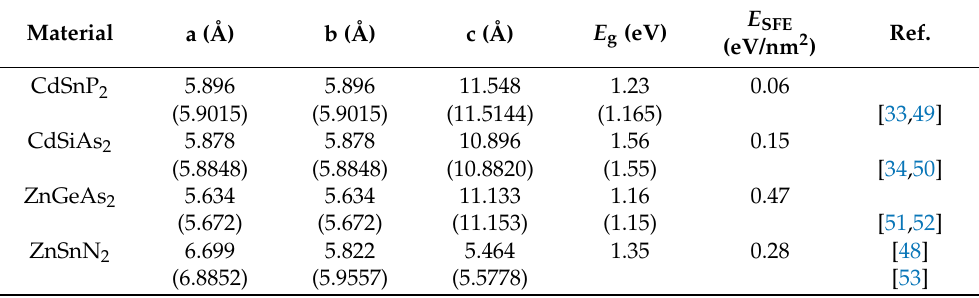
Table 1. Physical properties of the screened materials for single-junction solar cells. The lattice constants a , b , and c are those of the structure optimized by using SCAN+rVV10. The values in parentheses are experimental values. E g and E SFE stand for the electronic band gap and the stacking fault energy, respectively. The electronic band gap of ZnSnN 2 varies depending on the cation ordering